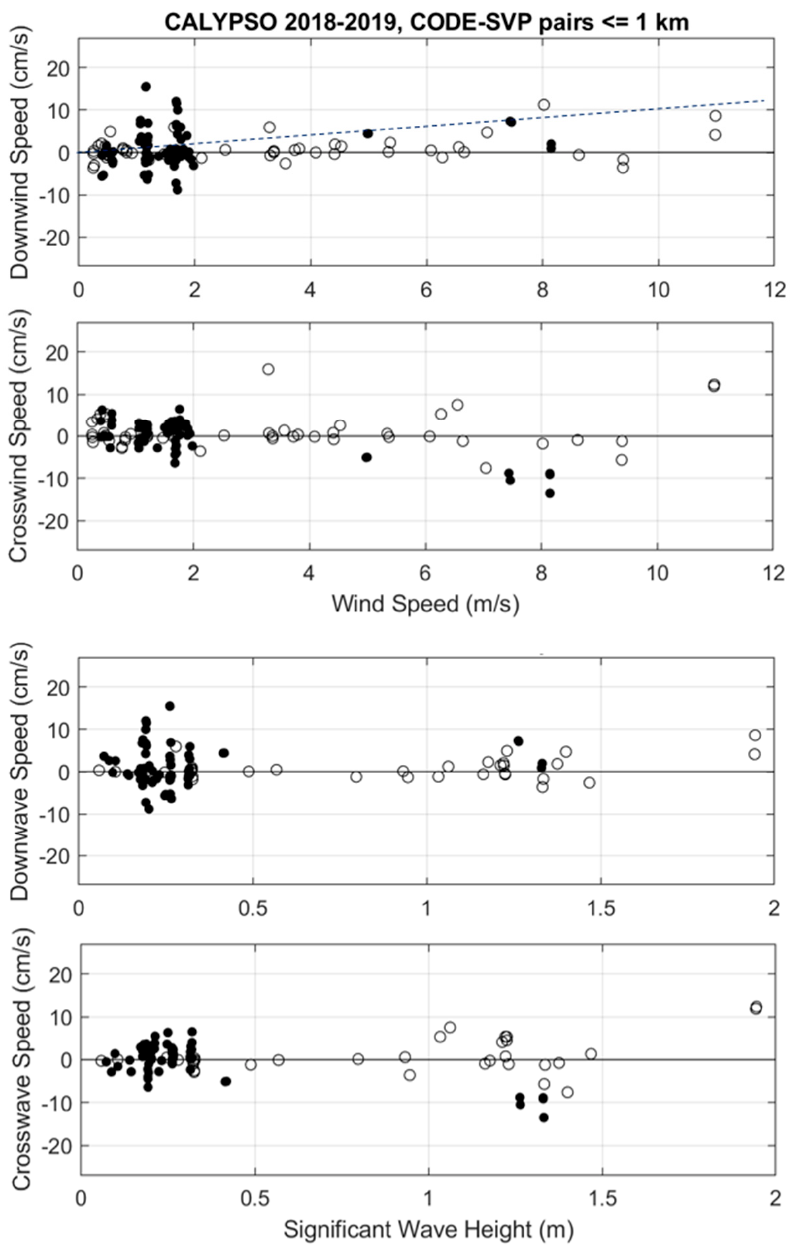
Figure 3. Down- and cross-wind components of velocity difference between CODE and SVP drifters versus ERA5 wind speed ( top panels ) and significant wave height ( bottom panels ): CALYPSO 2018 (black dots) and CALYPSO 2019 (circles). The 1% slope is shown as a dashed line in the top panel for reference.